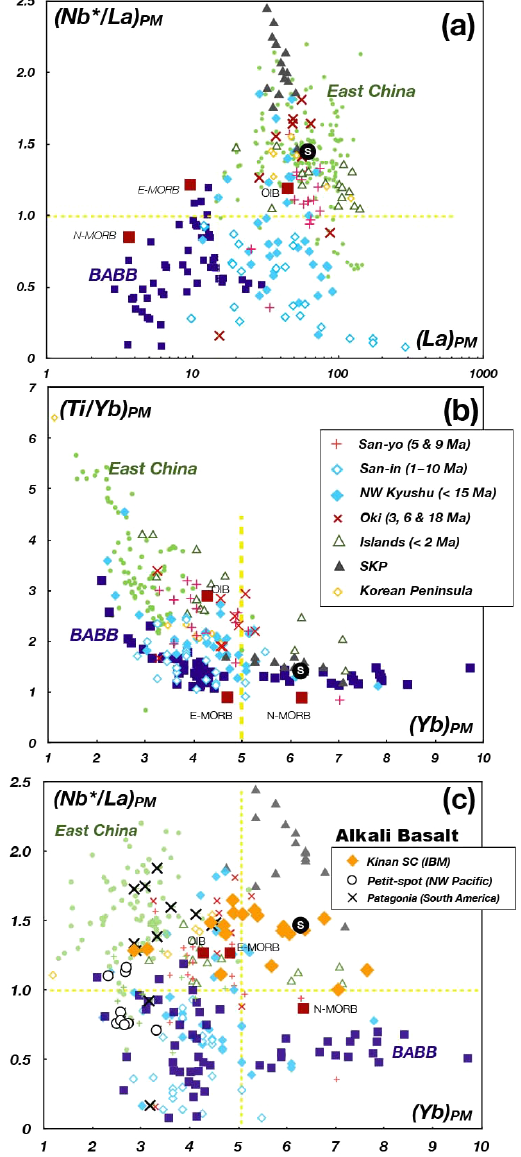
Figure 5. High-field-strength and rare earth element systematics of the SSM basalt (black circle annotated with S) and basalts from the circum-Sea of Japan area with SiO 2 <52.5wt% (Ulleung, Jeju Island, and Takeshima islands; SKP: South Korean Plateau). Nor- malizing values (primitive mantle) and reference basalt data (mid- ocean ridge basalt, MORB, and OIB) were taken from Sun and McDonough (1989). (a) Nb vs. La (Nb ∗ : Nb calculated by assum- ing that Nb PM / Ta PM = 1). (b) Ti vs. Yb (data sources are given in Fig. 3). (c) Discrimination of basalts based on the compositional relationships shown in (a) and (b) . Note that high-Nb / La and high- Yb basalts have rarely been reported from the circum-Sea of Japan area. Data for alkali basalts from the Kinan Seamount Chain in the Shikoku Basin (Izu–Bonin–Mariana region) (Ishizuka et al., 2009), petit-spot volcanoes in the western Pacific (Hirano et al., 2006), and Patagonia (South America) (Stern et al., 1990) are shown for com-